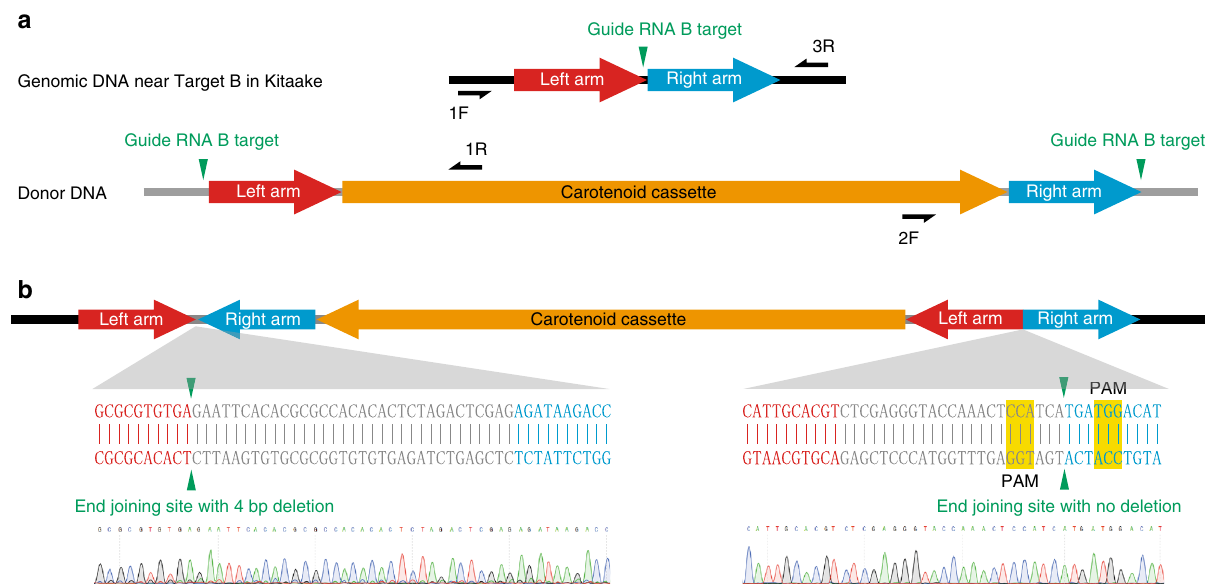
Fig. 2 Molecular characterization of the carotenoid cassette at Target B. a Diagrams showing the genomic region near Target B in Kitaake rice and the donor DNA. Gray lines represent plasmid backbone DNA while black lines represent Kitaake genomic DNA. The vertical green triangles mark the positions of the guide RNA B target sites. b Diagram of the inserted carotenoid cassette at Target B in T0 plants #11, 16, 17, 24, 28, 48, and 50. The junction sequences in all the seven plants are identical, as shown in the diagram. For convenience, only the sequencing chromatograms for T0 #48 are shown. The protospacer adjacent motif (PAM) of the original guide RNA B targets are highlighted in